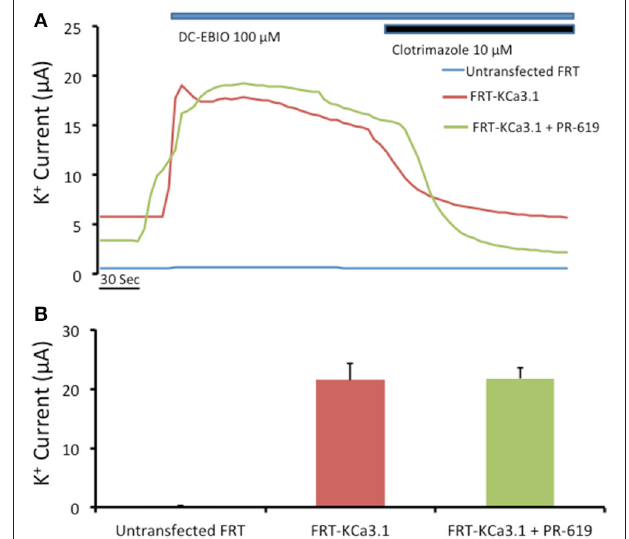
FIGURE 7 | Effect of PR-619 of membrane bound FRT-KCa3.1-BLAP cells. (A) Representative Ussing chamber traces of the PR-619 treated cells. FRT-KCa3.1-BLAP cells were grown on Snapwell TM filter inserts then subjected to Ussing chamber experiments. Once again, DCEBIO (100 µ